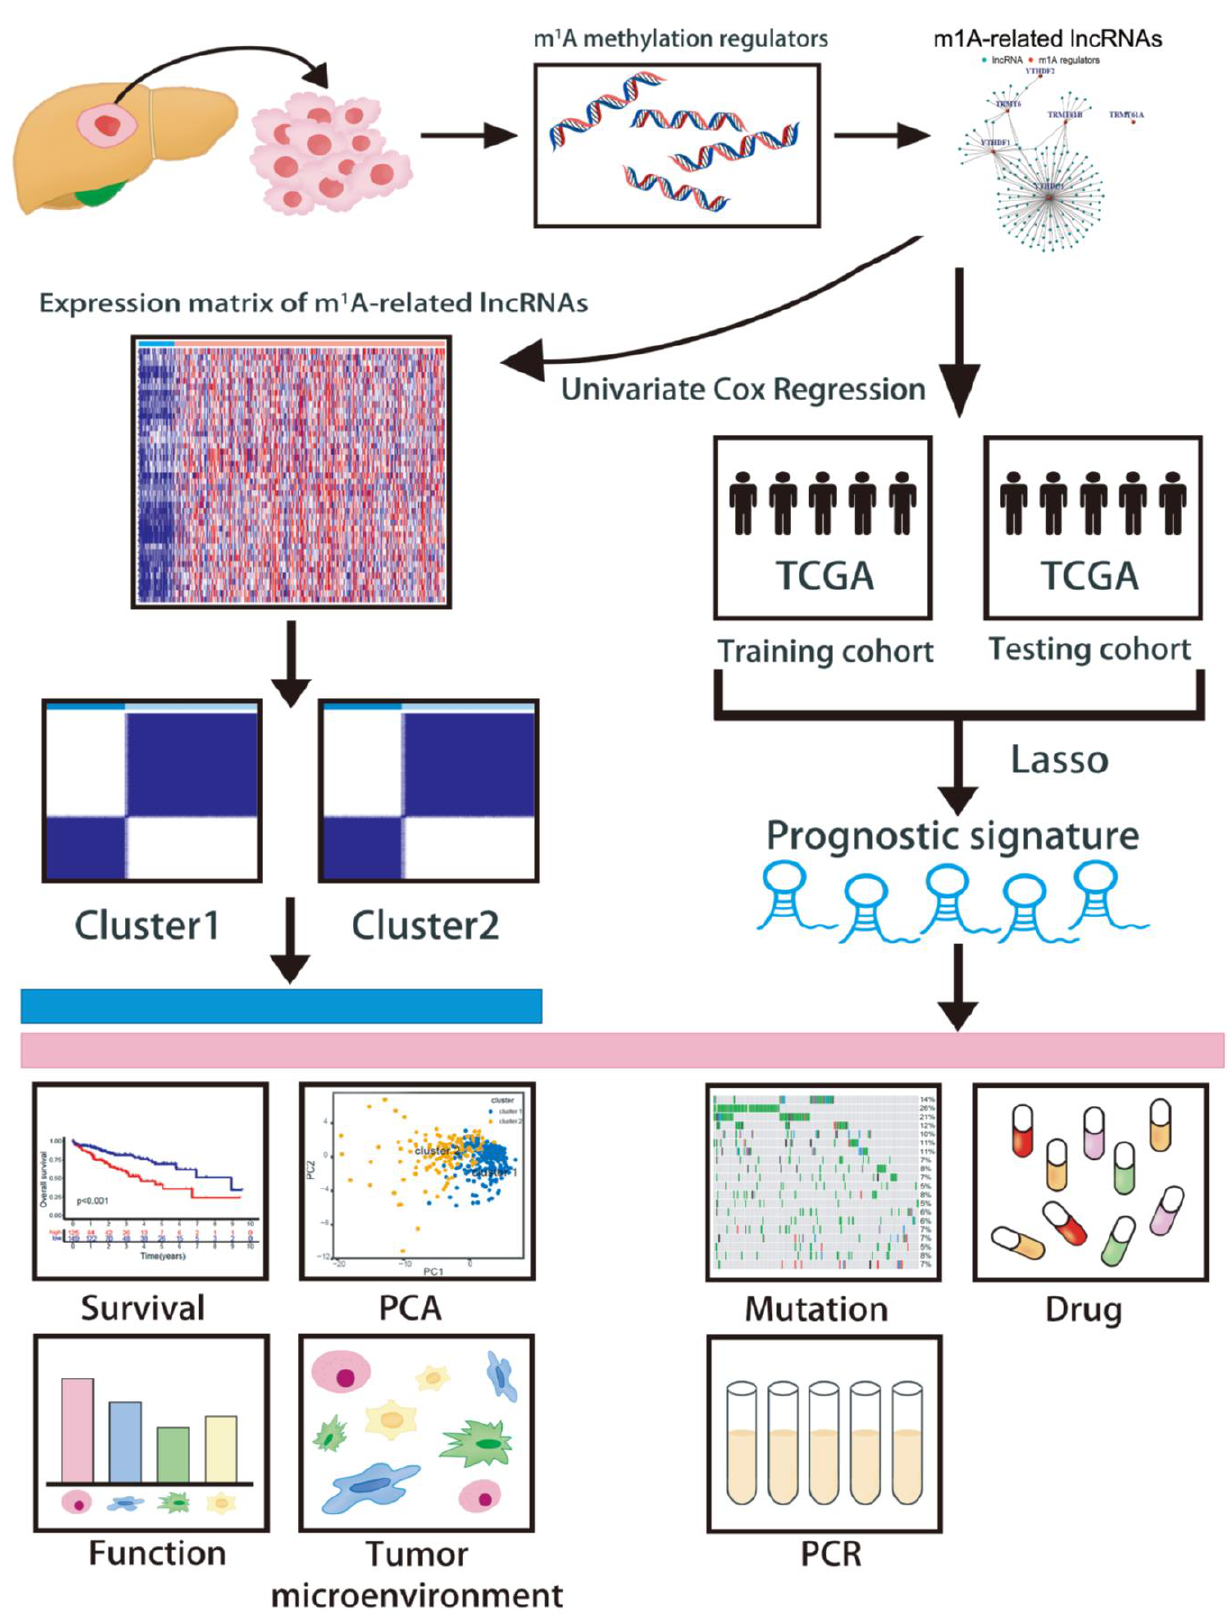
Figure 1. The flowchart of this study.